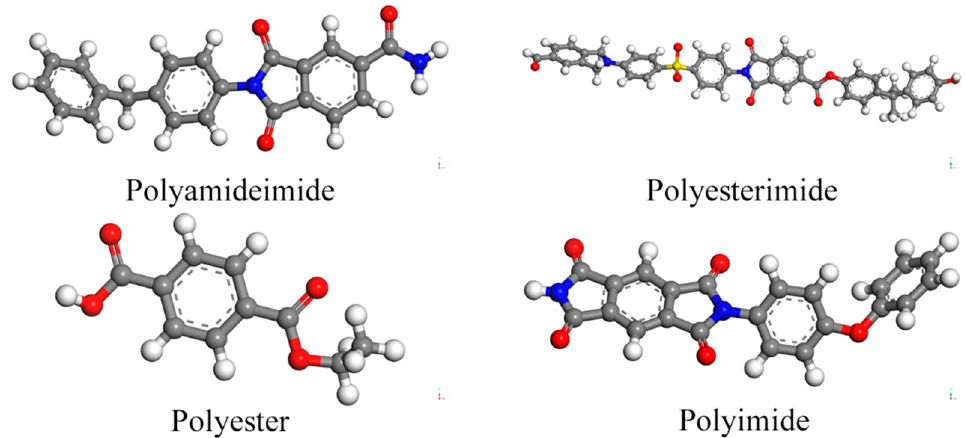
Figure 2. The optimized structure of PAI, PEI, PET and PI polymer monomers.